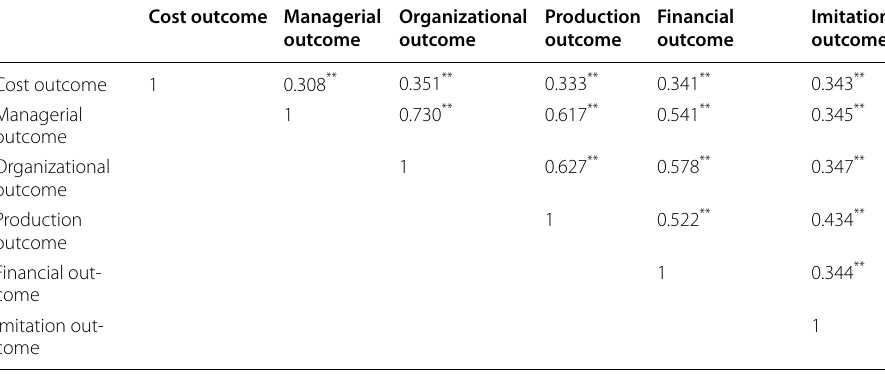
Table 1 Correlation table of the perceived complexity variables